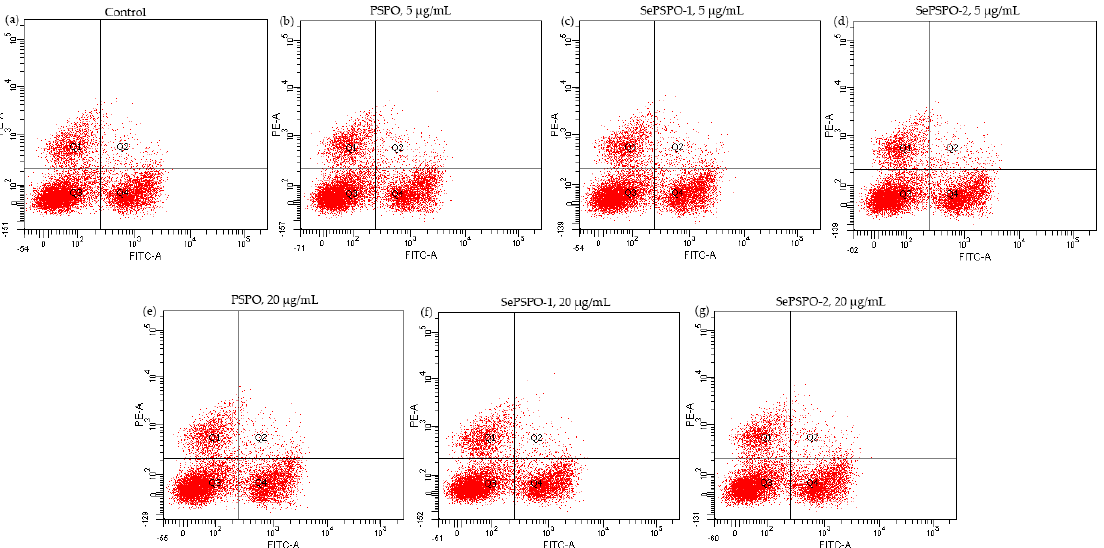
Figure 4. The obtained flow cytometry pictures for the control cells ( a ), and those cells incubated with PSPO ( b ), ( e ), SePSPO-1 ( c ), ( f ), and SePSPO-2 ( d ), ( g ) at the doses of 5 and 20 μ g/mL, respectively. Table 2. The measured T lymphocyte subpopulations in the Con A-treated splenocytes that were incubated with PSPO, SePSPO-1, and SePSPO-2 for 48 h. Cell Group Dose ( µ g/mL)